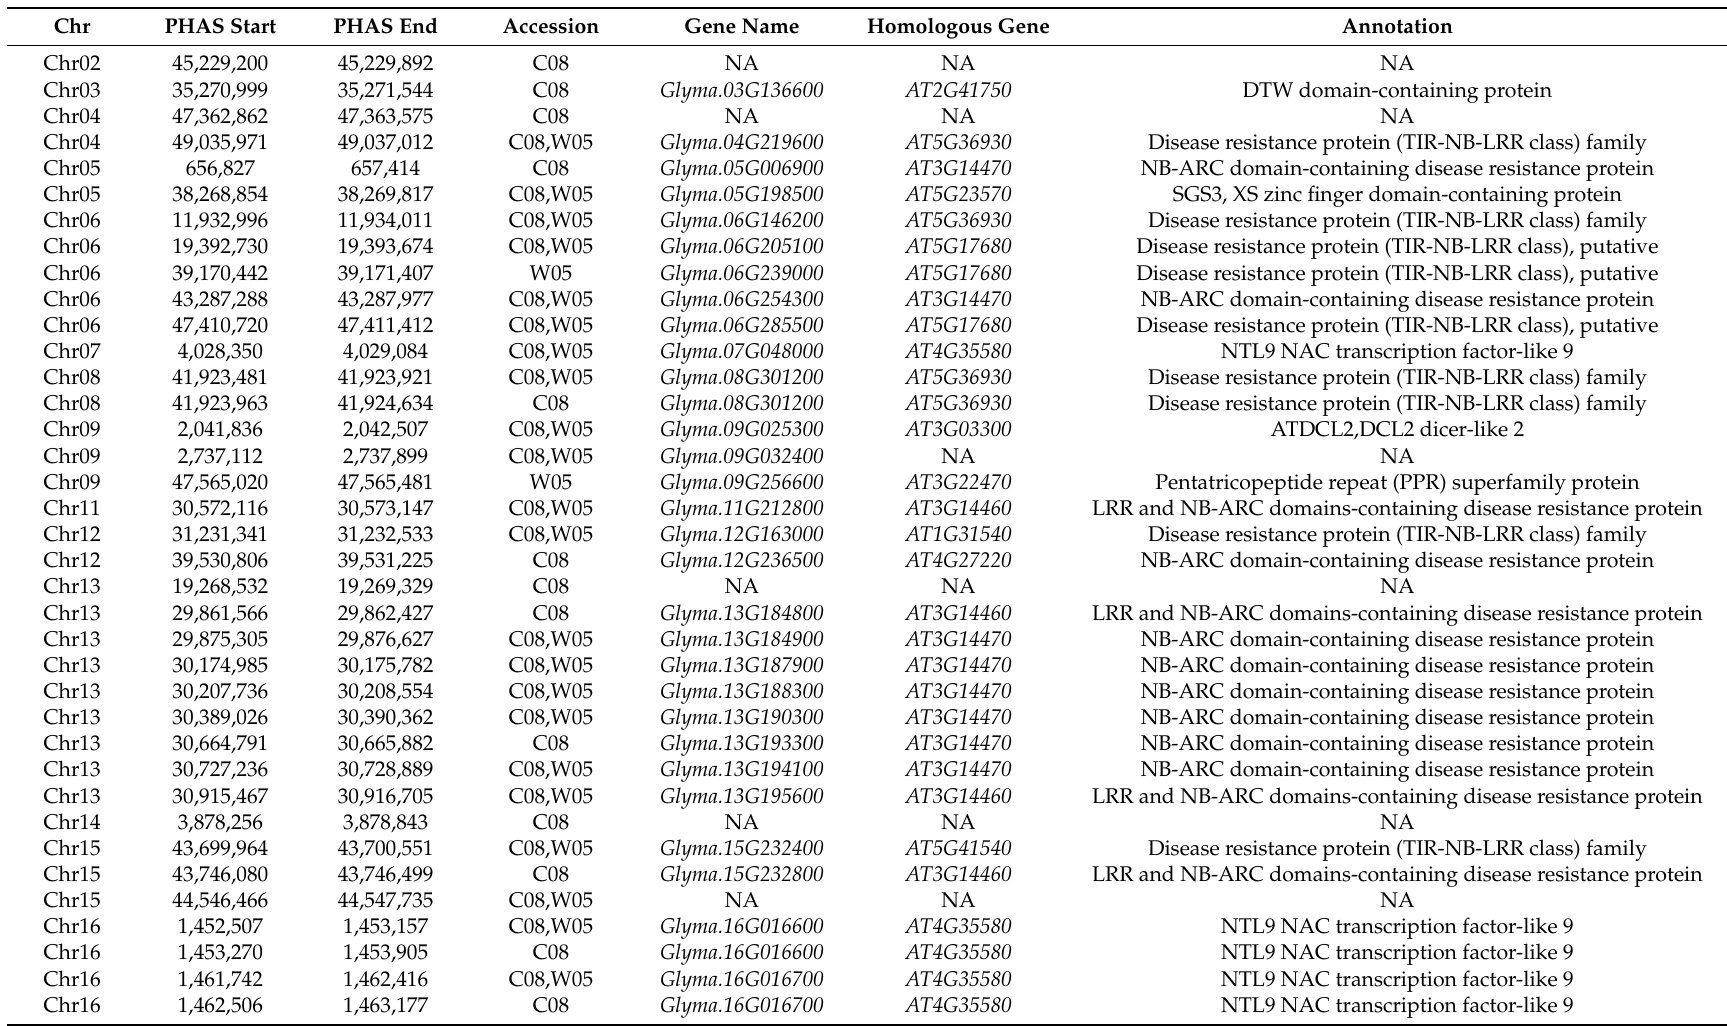
Table 1. PHAS regions and their annotations in